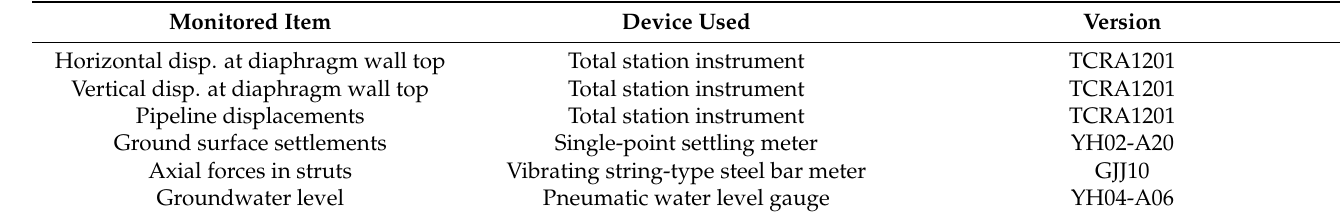
Table 4. Summary of the monitoring devices used in this deep-braced excavation and their